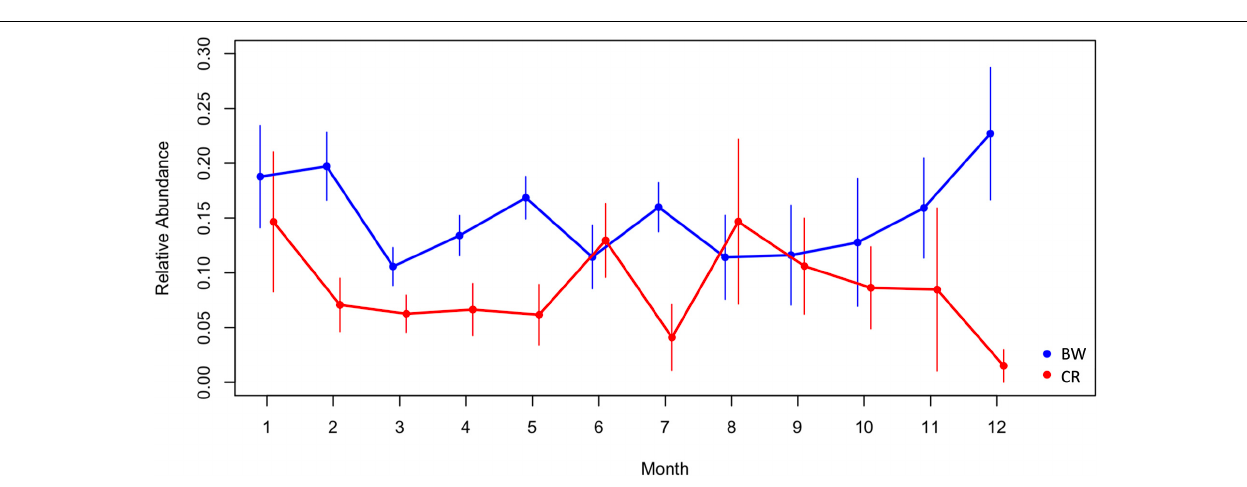
FIGURE 5 | Relative abundance and seasonality BW and CR across months aggregated over the study period. Relative abundance = log(abundance + 1)/survey effort. Error bars indicate standard errors of the